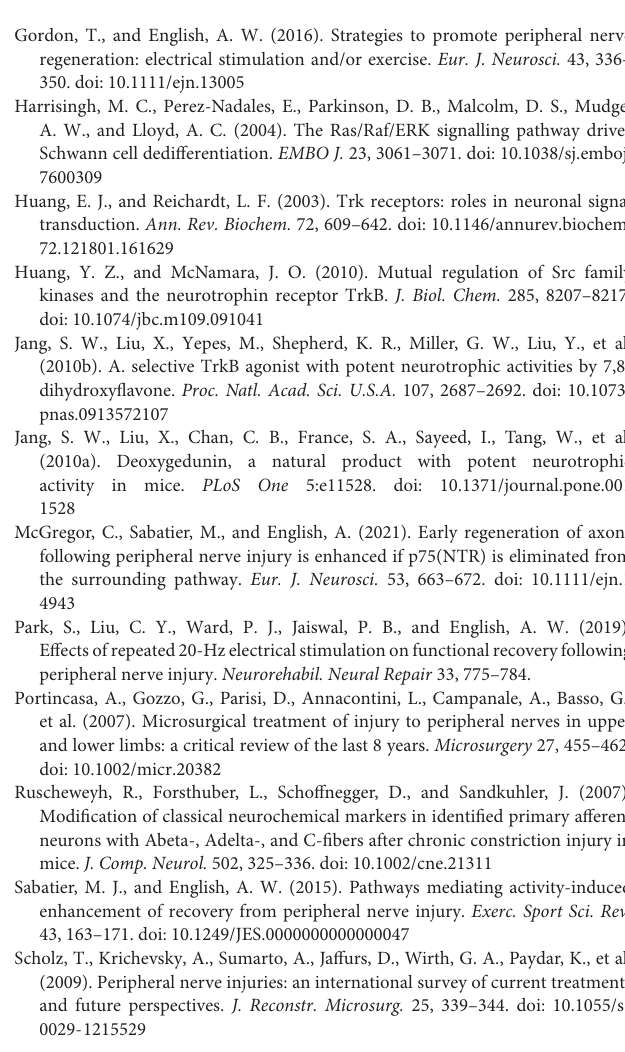
Supplementary Figure 1 | Immunoblots of extracts of cut and repaired sciatic nerves from mice that had been administered the R13 vehicle (5% DMSO/0.5% methylcellulose) orally. The different lanes are from nerves collected at different times (minutes) after administration. Administration of the vehicle produced no notable change in TrkB activation (pTrkB Y705) or in either of the downstream effectors, AKT or